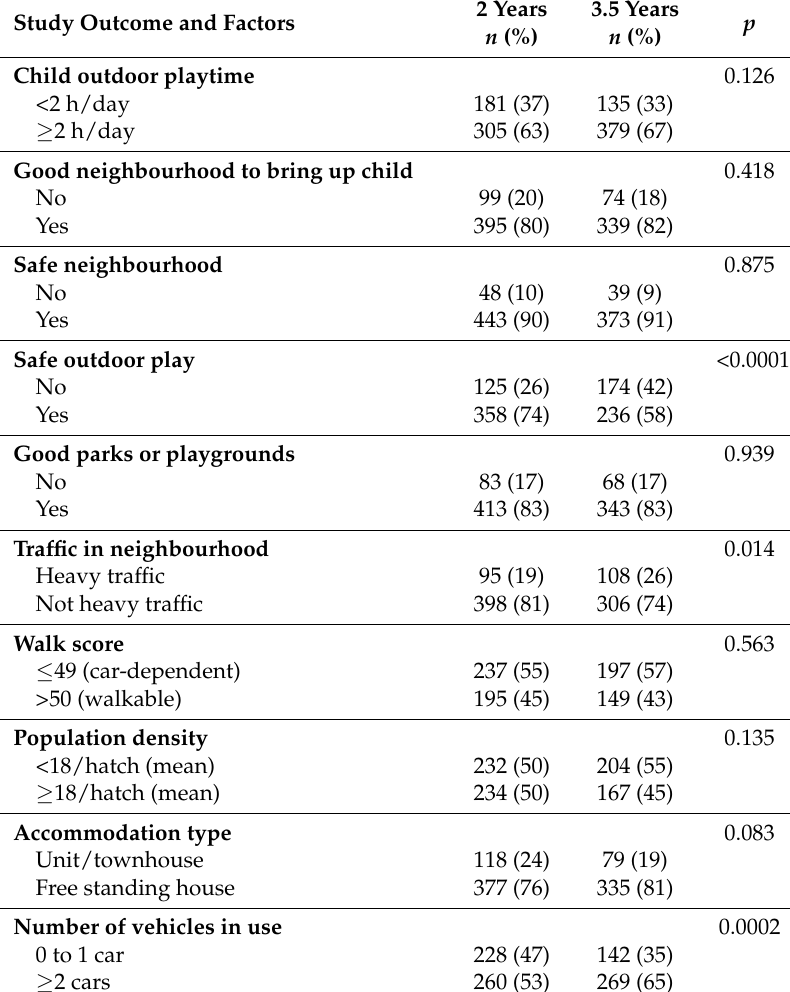
Table 2. Descriptive statistics of study factors and outcomes at ages 2 and 3.5